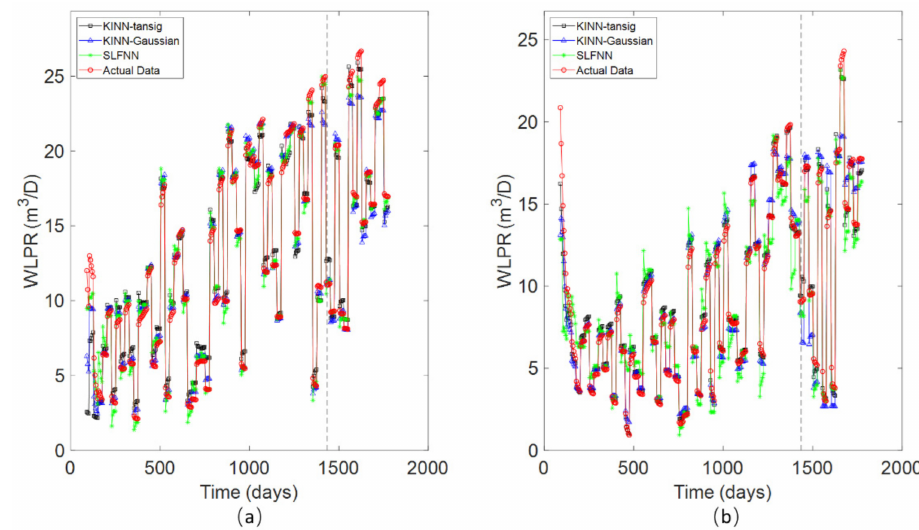
Figure 6. History matching results of the streak reservoir case by KINN-tansig, KINN-Gaussian and SLFNN. The black line with squares is the result obtained by KINN-tansig method; the blue line with triangles represents the result gotten by KINN-Gaussian method; the green line with stars is the results obtained by SLFNN; the red line with circles is the liquid production rate gotten by ECLIPSE; the grey vertical dashed line makes a separation of history matching period and the productivity forecast period: ( a ) P1; ( b ) P4.